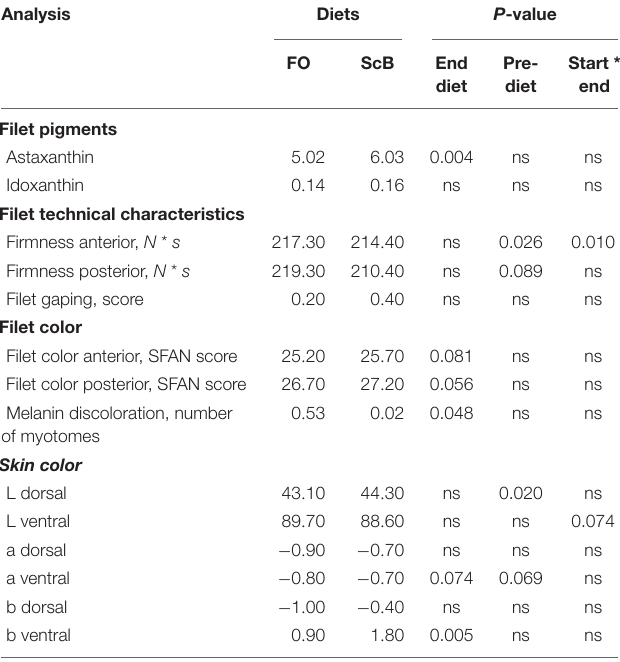
TABLE 8 | Filet astaxanthin and idoxanthin levels (mg/kg), firmness ( N * s ), gaping- and color score, and colorimetric evaluation of skin coloration of A. salmon fed life-long different pre-diets and end-diets supplemented with either fish oil (FO) or Schizochytrium limacinum biomass (ScB) as n-3 LC-PUFA